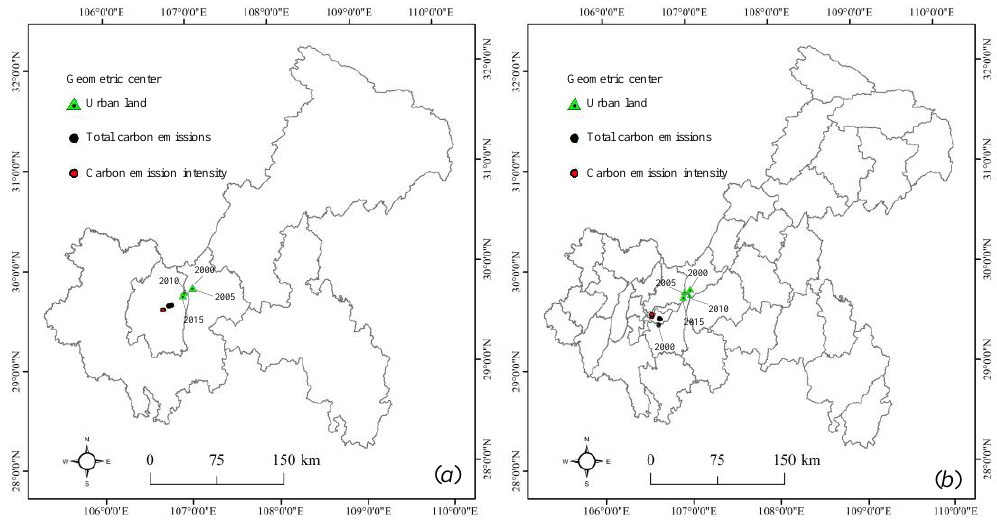
Figure 6. The geometric center shift of urban land and carbon emissions in Chongqing. Note: ( a ) regional scale; ( b ) county scale .